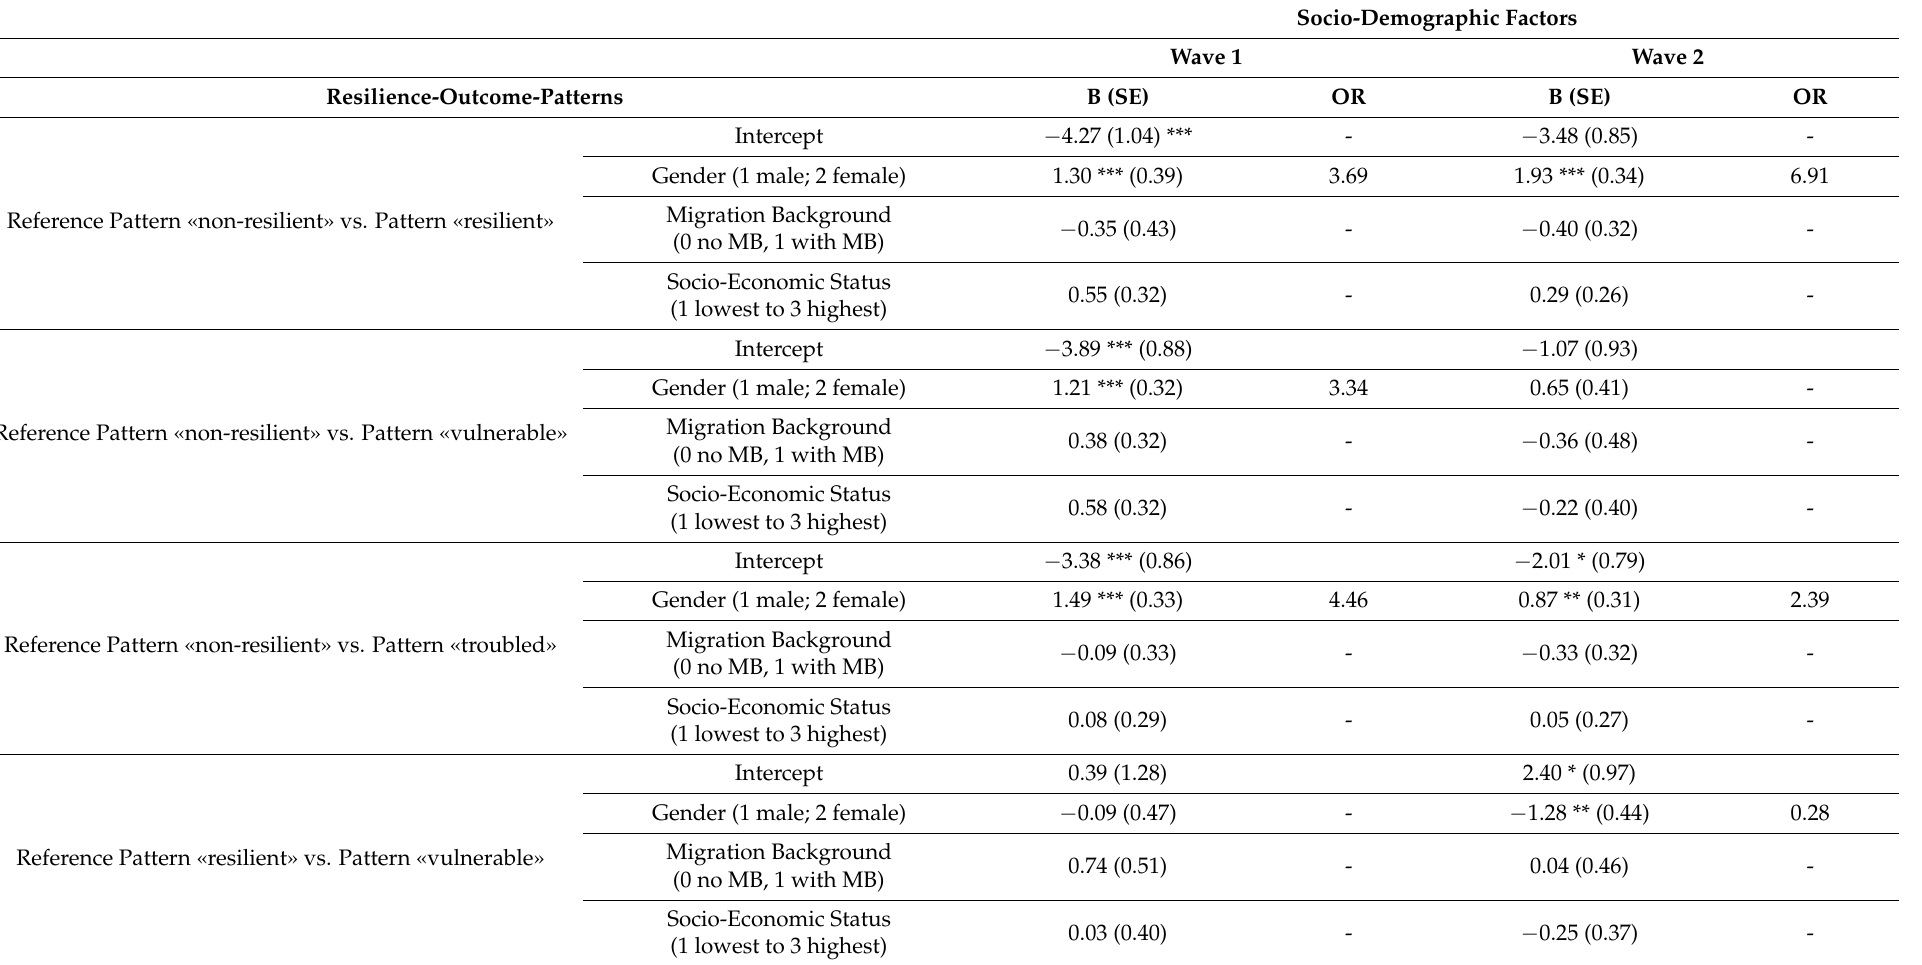
Table 6. Wave 1 and wave 2, multinomial logistic regression of socio-demographic covariates to the identified latent status membership on the four resilience-